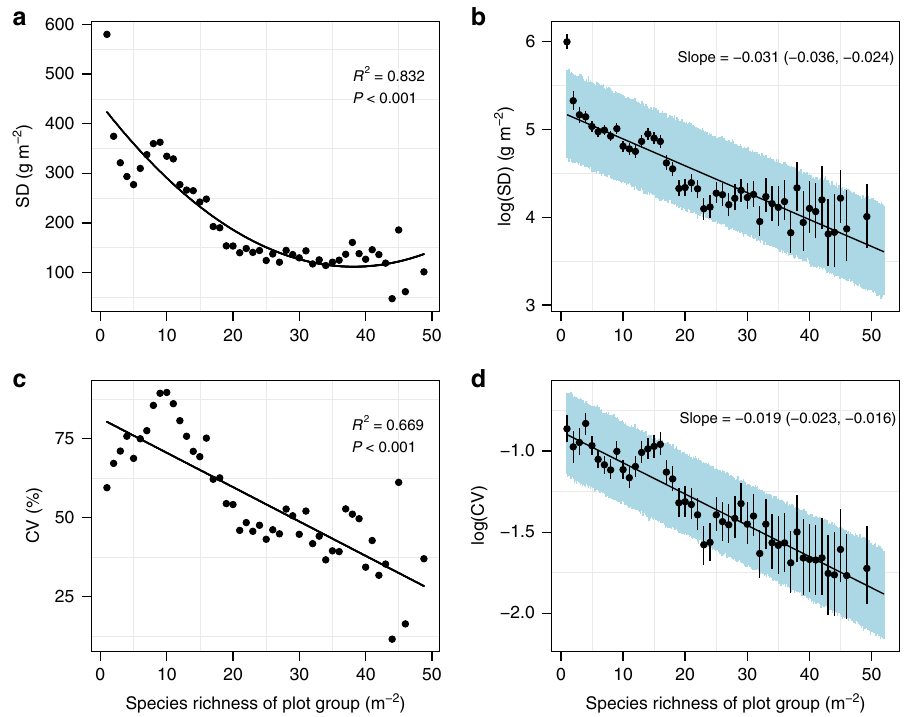
Fig. 6 Global relationship between biodiversity and spatial variability N ¼ 47 plot groups ð Þ . a , c Simple regression models. b , d Hierarchical Bayesian models. Black points and vertical lines in b , d show the medians and 95% credible intervals (CI) of log-transformed productivity variation for each species richness level. Spatial variability in grassland productivity was measured as standard deviation (SD, top panel) or coef fi cient of variation (CV, bottom panel) across plots with the same richness. The black line represents the fi tted relationship. The shaded areas in panels b and d represent the 95% CI of the fi tted relationships. The texts in panels b and d show the median and 95% CI of the slope. Species richness was used to group plots containing one, two, three species, etc. Because some high-richness levels had only one or two plots at each richness level, the 9640 plots were divided into 47 plot groups, with the last group containing 47 − 52 species, to ensure there were three or more plots in each group. Source data are provided as a Source Data fi